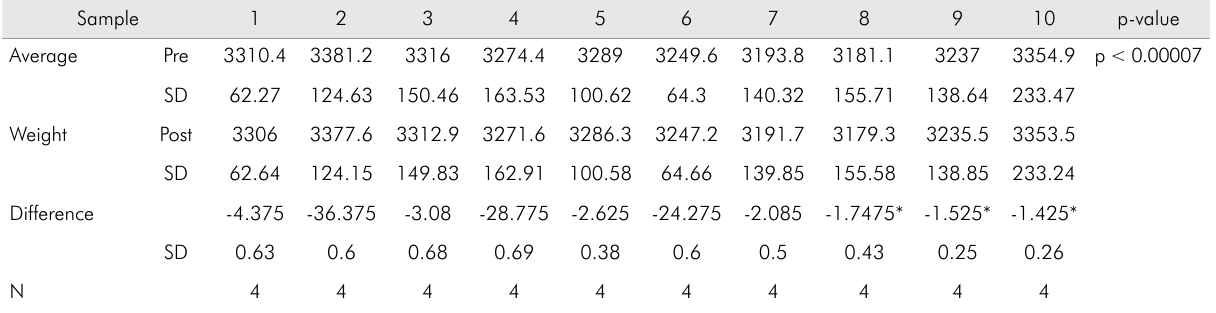
Table 2. Mean weight (mg) and mean difference in weight after each file use (mg) in the simulated root canals after each use of the Reciproc ® R25